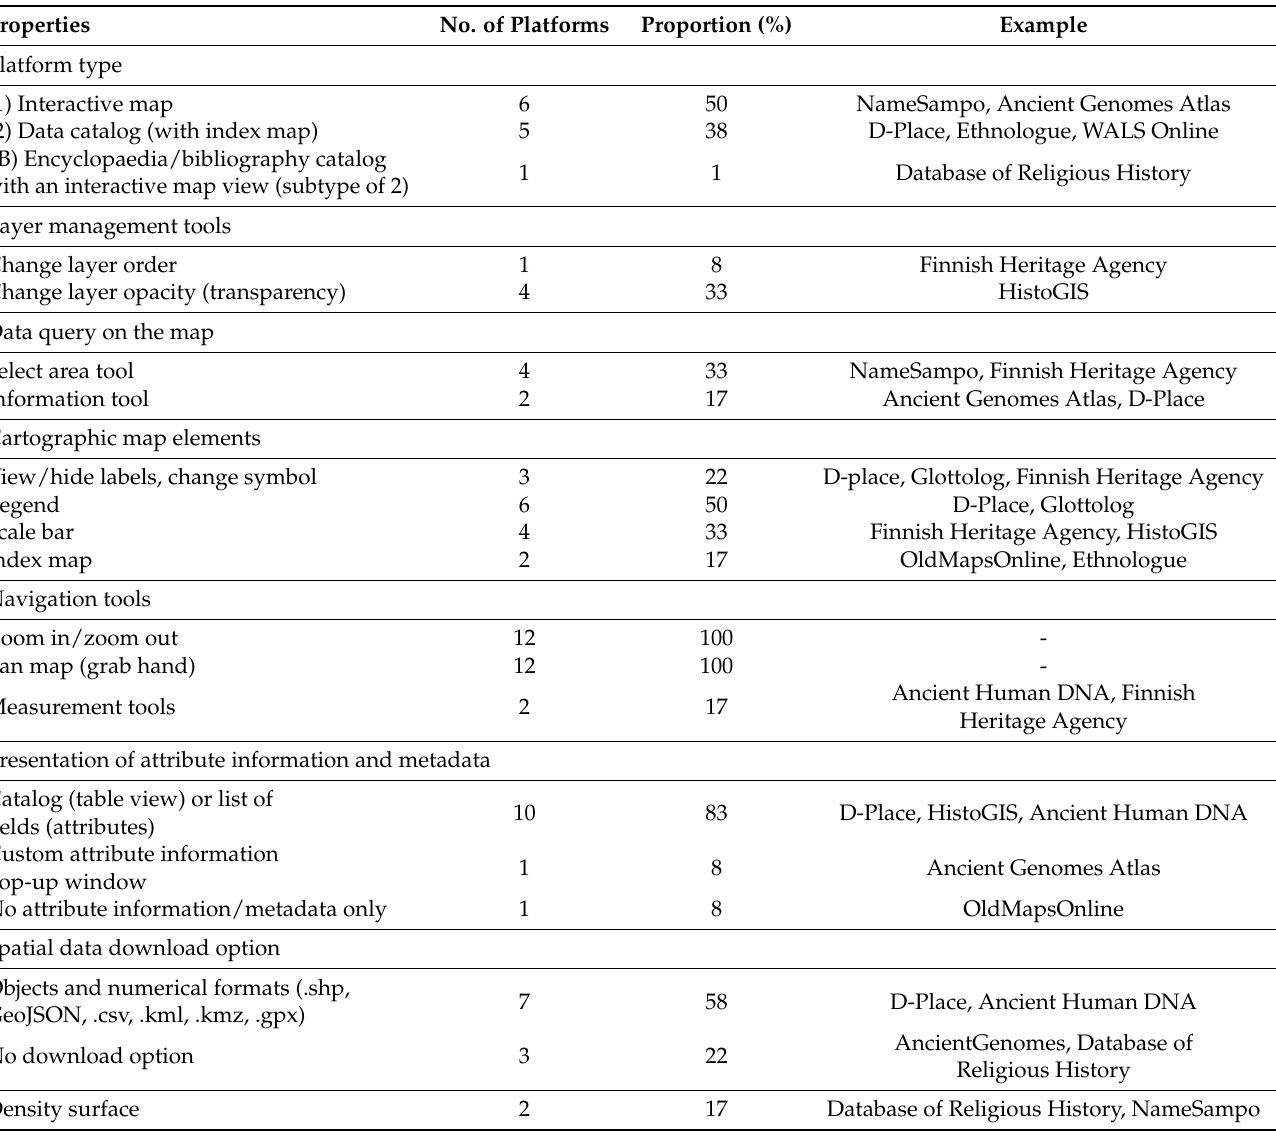
Table 5. Spatial data platforms classified by properties of architecture and main